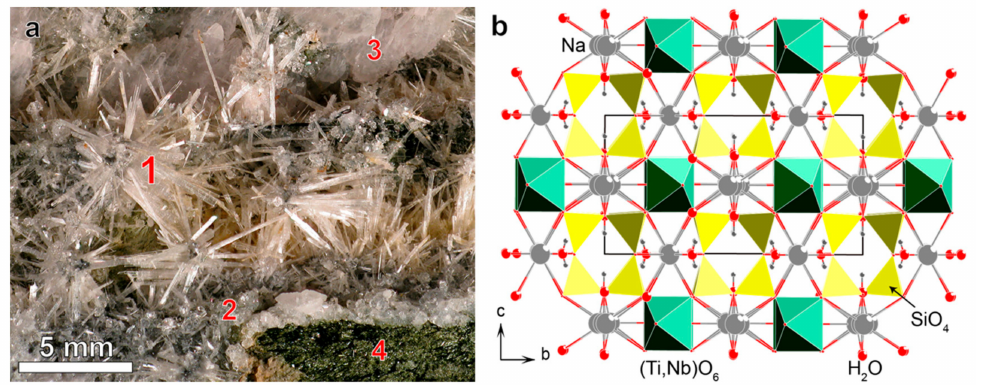
Figure 2. Radiated aggregates and long prismatic crystals ( a ) and crystal structure of korobitsynite (( b ), after [21]). 1—korobitsynite, 2—quartz, 3—albite,